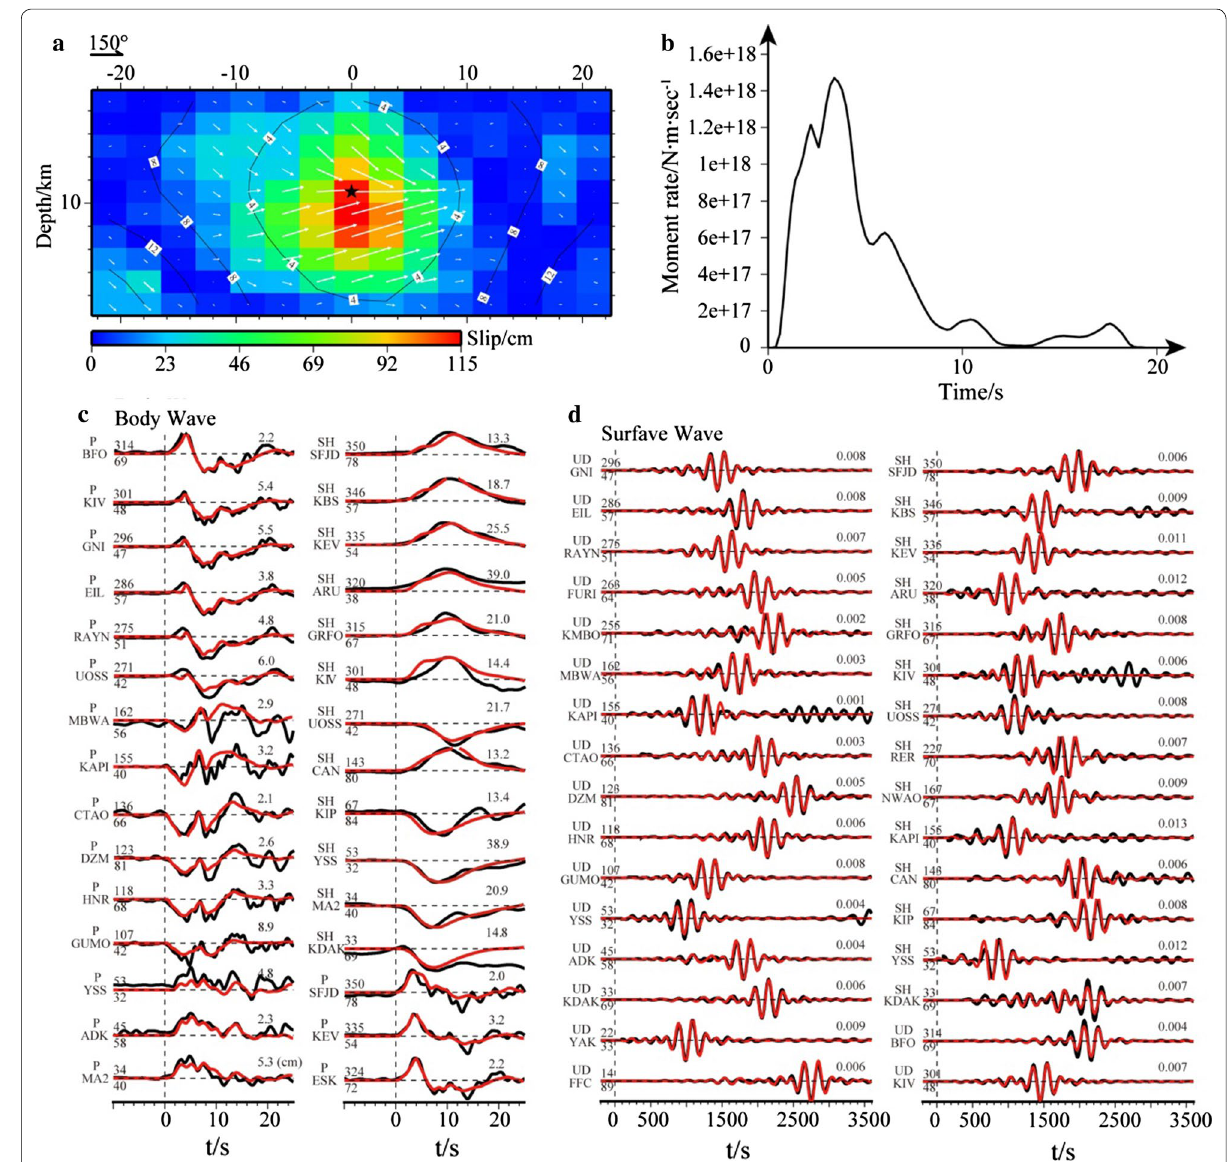
Fig. 2 Inversion results of the 2013 Lushan earthquake. a Slip distribution on the fault plane, the star represents the epicenter, the size and direction of the arrows represent the slip size and slip direction, the number is the rupture propagation time. b Scalar seismic moment rate evolution versus time. c Match of observed teleseismic body waves and synthetic waveforms; d match of observed teleseismic surface waves and synthetic waveforms, the black line and red line indicate the observed record and synthetic seismogram, the station, azimuth, epicentral distance and the maximum in observation (in cm) are also